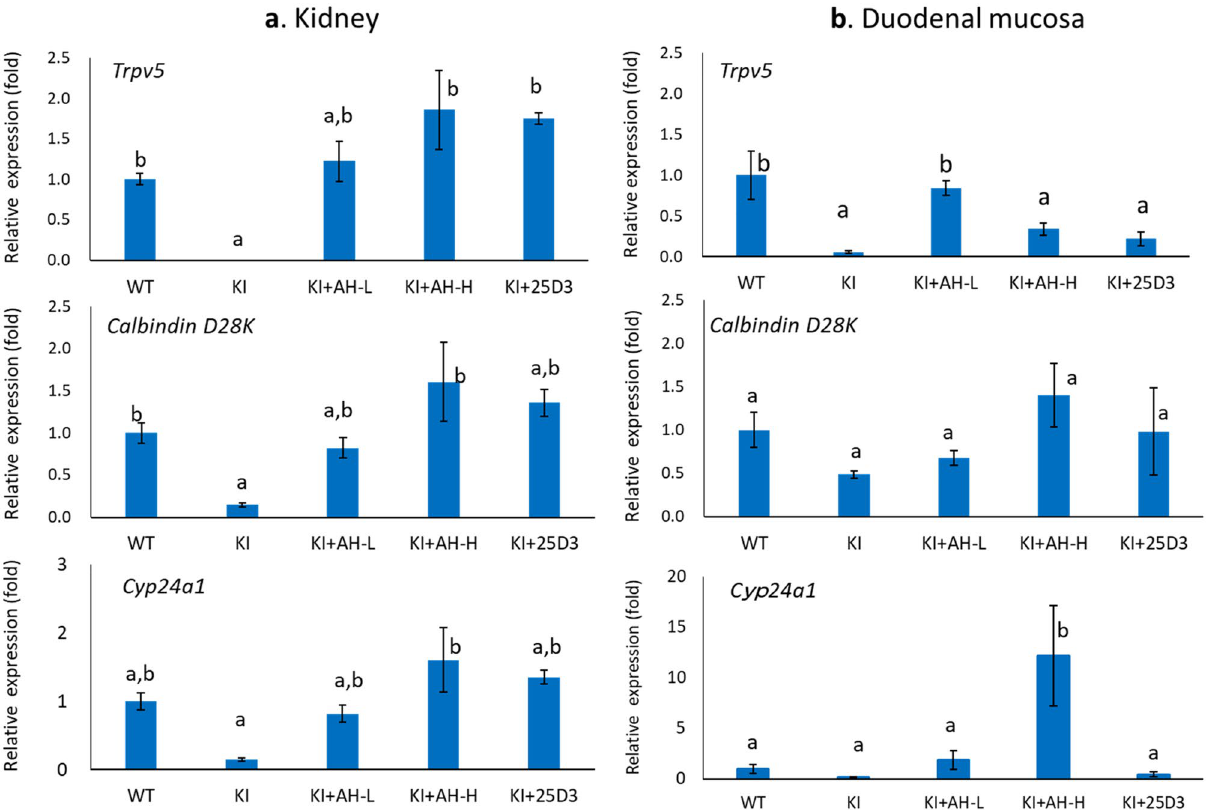
Figure 6. Transcriptional activity of AH-1 on Vdr target genes in intestine and kidney. Relative mRNA expression of Trpv 5 , Calbindin D28K and Cyp24a1 in kidney ( a ) and duodenal mucosa ( b ). Values are the means ± SEM (n = 4–8 animals/group). Different letters: p < 0.05 by 2-way